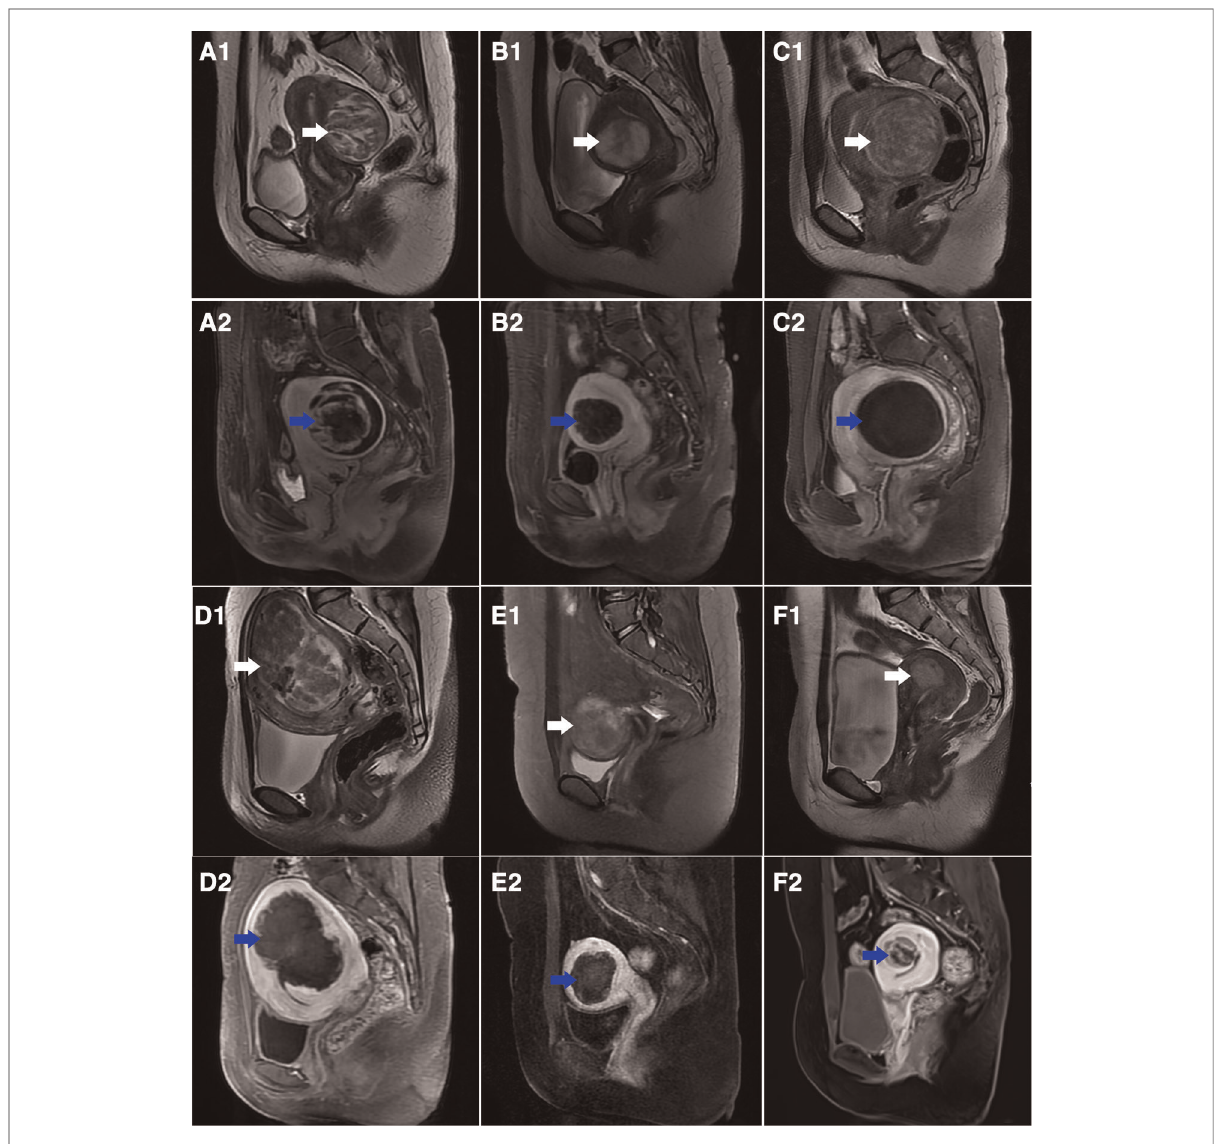
FIGURE 3 T2-weighted sagittal MR images of different sub-types of hyperintense fi broids before treatment and contrast-enhanced MR images after treatment. ( A1 – C1 ) T2-weighted images in the sHIFU group before treatment (white arrow): ( A1 ) heterogeneous hyperintense; ( B1 ) markedly homogeneous hyperintense; ( C1 ) slightly homogeneous hyperintense; ( A2 – C2 ) contrast enhanced MR images after treatment counterpart to A1 , B1 , C1 (blue arrow), the NPV is showed inside uterine fi broids: ( A2 ) NPVR=88.7%; ( B2 ) NPVR=68.9%; ( C2 ) NPVR=98.3%. ( D1 – F1 ) T2-weighted images in Gn- HIFU group before treatment (white arrow): ( D1 ) heterogeneous hyperintense; ( E1 ) markedly homogeneous hyperintense; ( F1 ) slightly homogeneous hyperintense; ( D2 – F2 ) contrast enhanced MR images after treatment counterpart to D1 , E1 , F1 (blue arrow), the NPV is showed inside uterine fi broids: ( D2 ) NPVR=76.2%; ( E2 ) NPVR=58.5%; ( F2 )